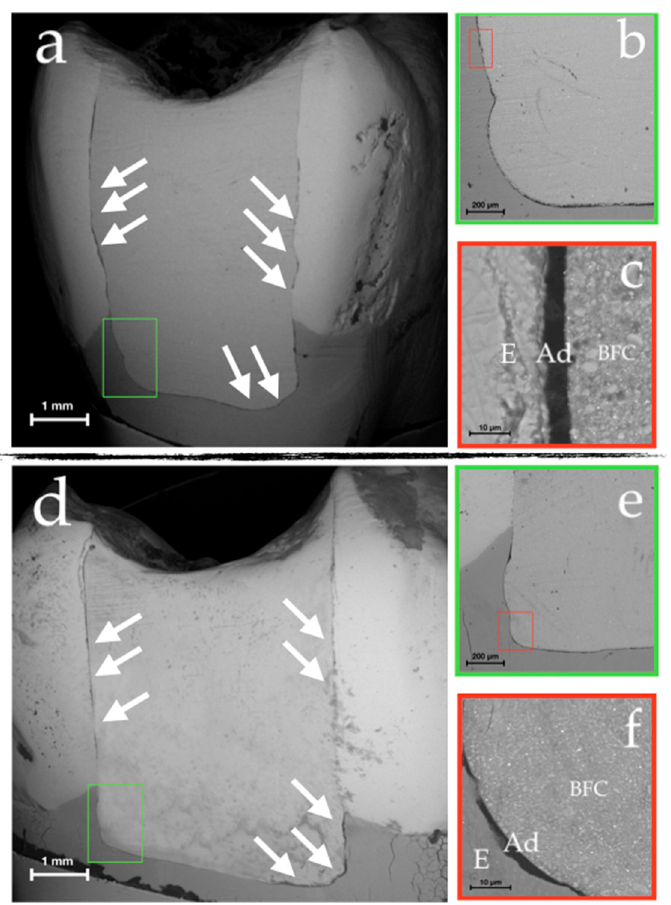
Figure 3. This scanning electron micrographs display a representative mesial view of class II resto- ration of BG (Bulk&Go group) and BT (Bulk Traditional) sample (( a , d ), respectively). The green inset ( b , e ) shows the tooth–restoration interface, which at higher magnification (red inset, ( c , f )) highlights the presence of three different structures: Enamel (E), adhesive layer (Ad) and bulk-fill composite (BFC), without any gap formation on the external margin.